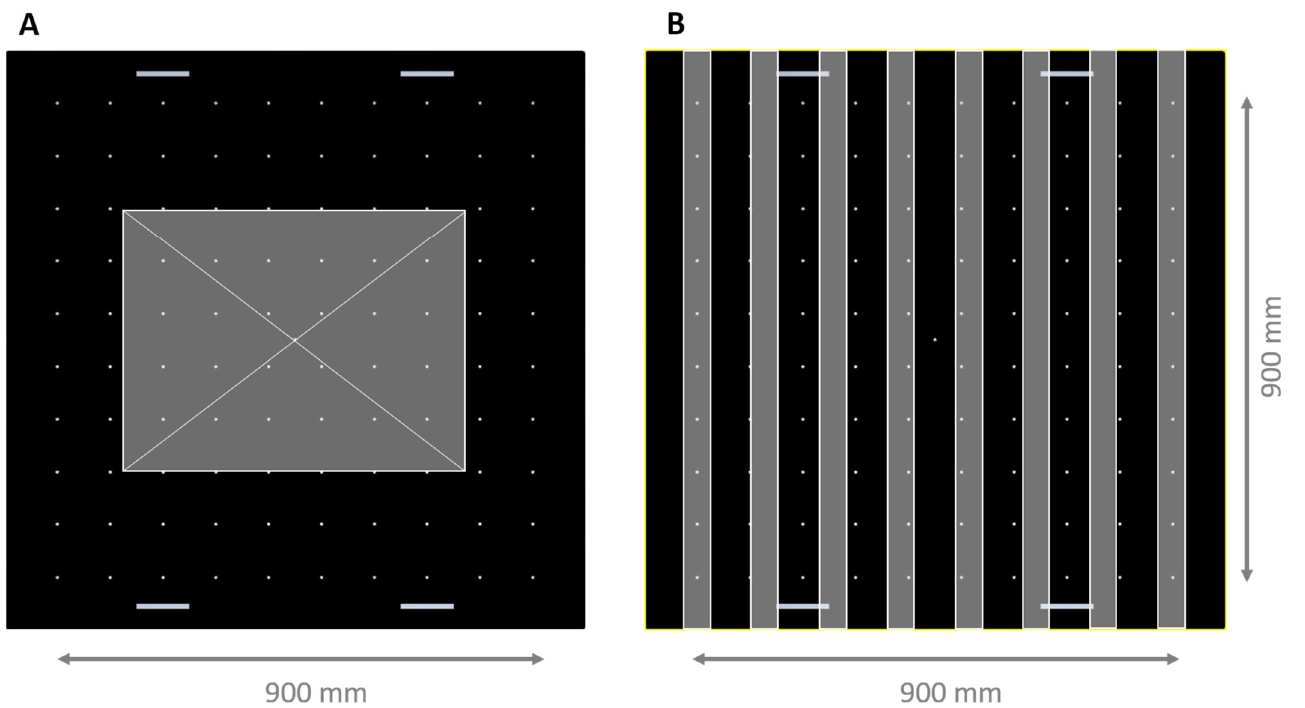
Figure 1. Schematic of the 10 × 10 measurement grid (black) with the outline of the luminaires (gray) for illumination settings ( A ),( B ). The hanging heights of the luminaires were 1612 mm ( A ) and 200 mm ( B ) above the measurement plane. The distance between the grid points was 100 mm in both directions of the horizontal plane.